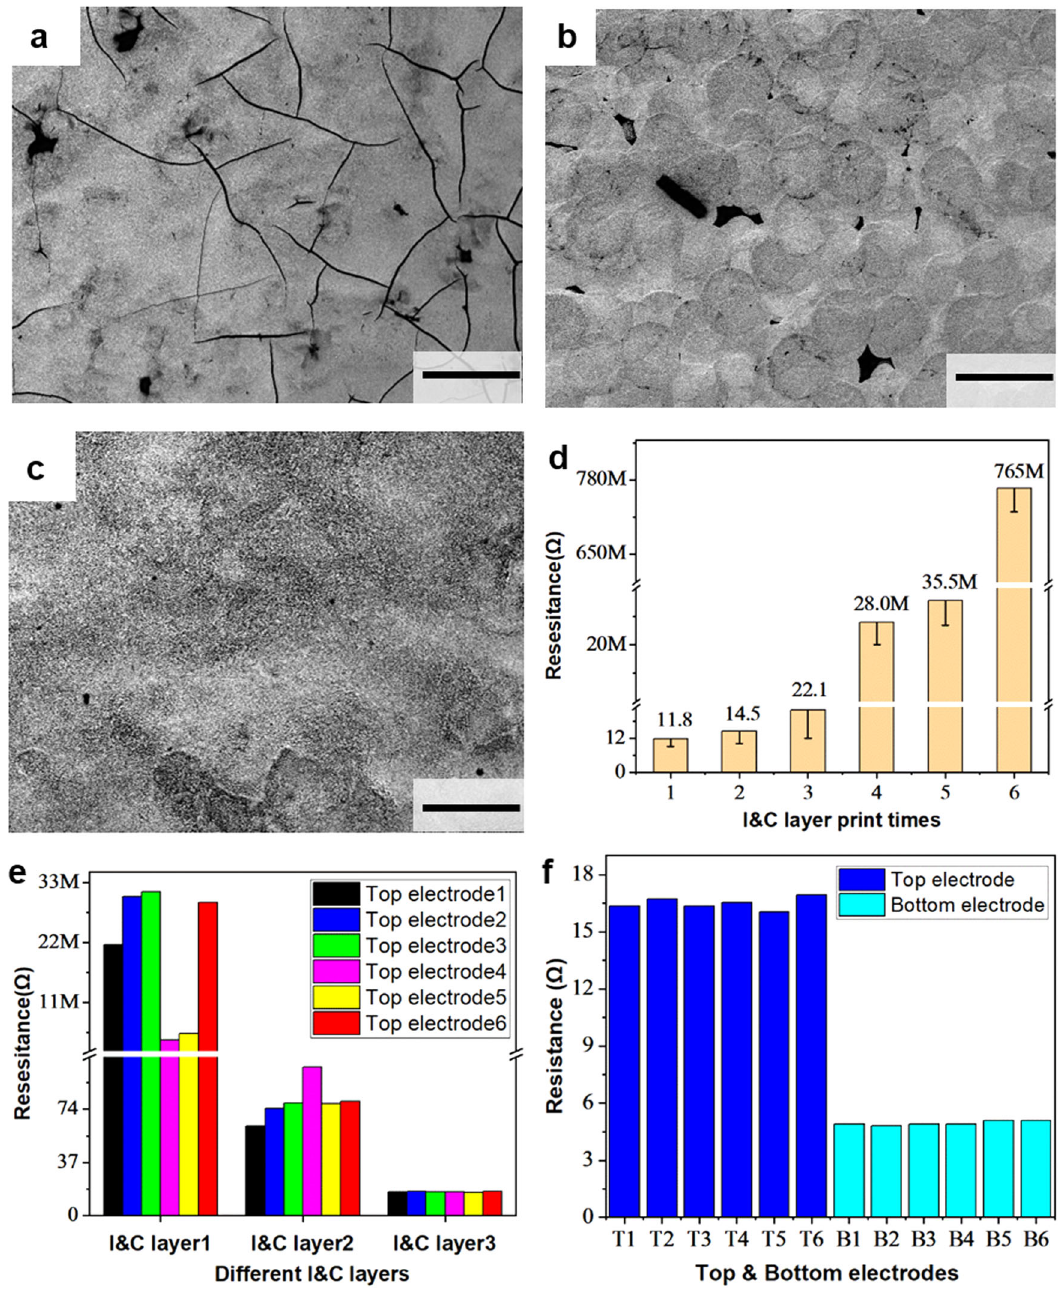
Fig. 3 Insulation and ink fi xing functions of I&C layer. SEM images of top (column) silver electrode printing effects, a without adding other polymers, b with the addition of polyethylene glycol (PEG), and c with the addition of M-30 polymer to the insulating ink. d Change of resistance between row and column electrodes versus the number of times I&C layers are printed using insulating ink with added M-30. e Comparison of resistance values of top silver electrodes printed on three insulating layer types. f Comparison of resistance values of the bottom (row) and top (column) silver electrodes of sensor matrix with I&C layers made from insulating ink with added M-30. Scale bars are 30 μ m for ( a – c